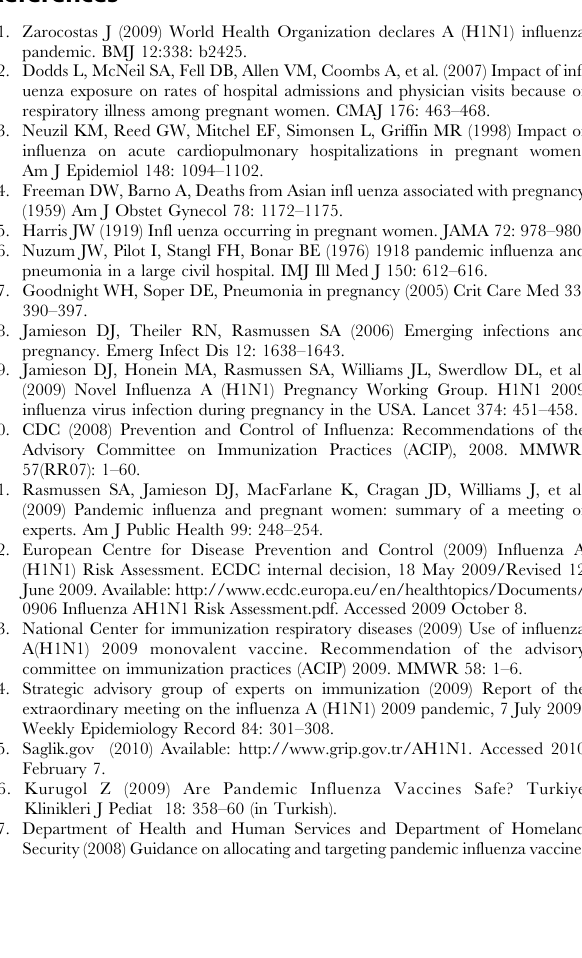
Table S1 Distribution of answer ‘yes’ given by 314 pregnant women concerning 2009 H1N1